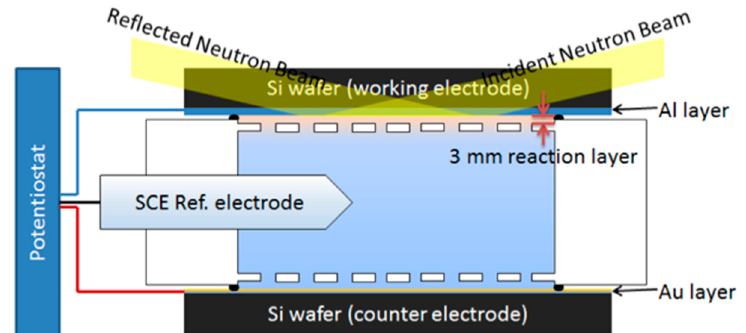
Figure 6. Schematic of the NR electrochemical cell used by Dong et al. where reflectivity measurements are taken from the working electrode (Al film on Si) to monitor its corrosion at different applied potentials. Reproduced with kind permission from [67], ACS Publications, 2011.